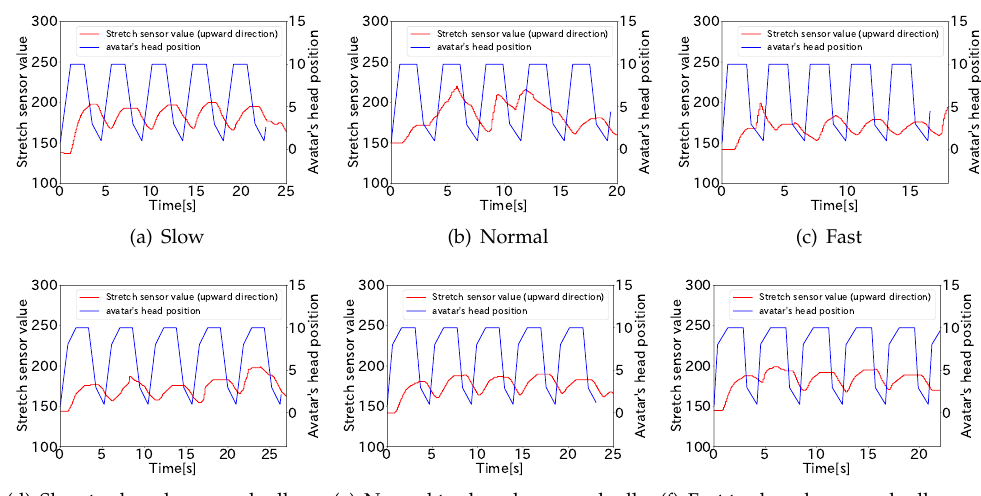
(f) Fast to slow down gradually at the top